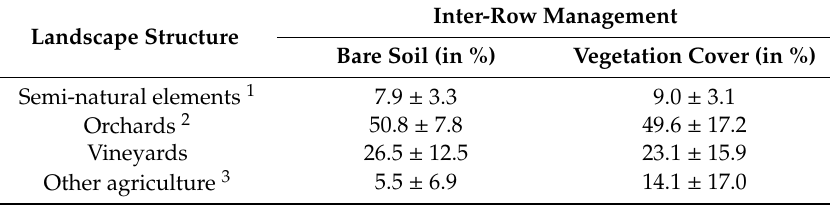
Table 1. Surrounding landscape types for the studied vineyards. Numbers are mean percentages ±